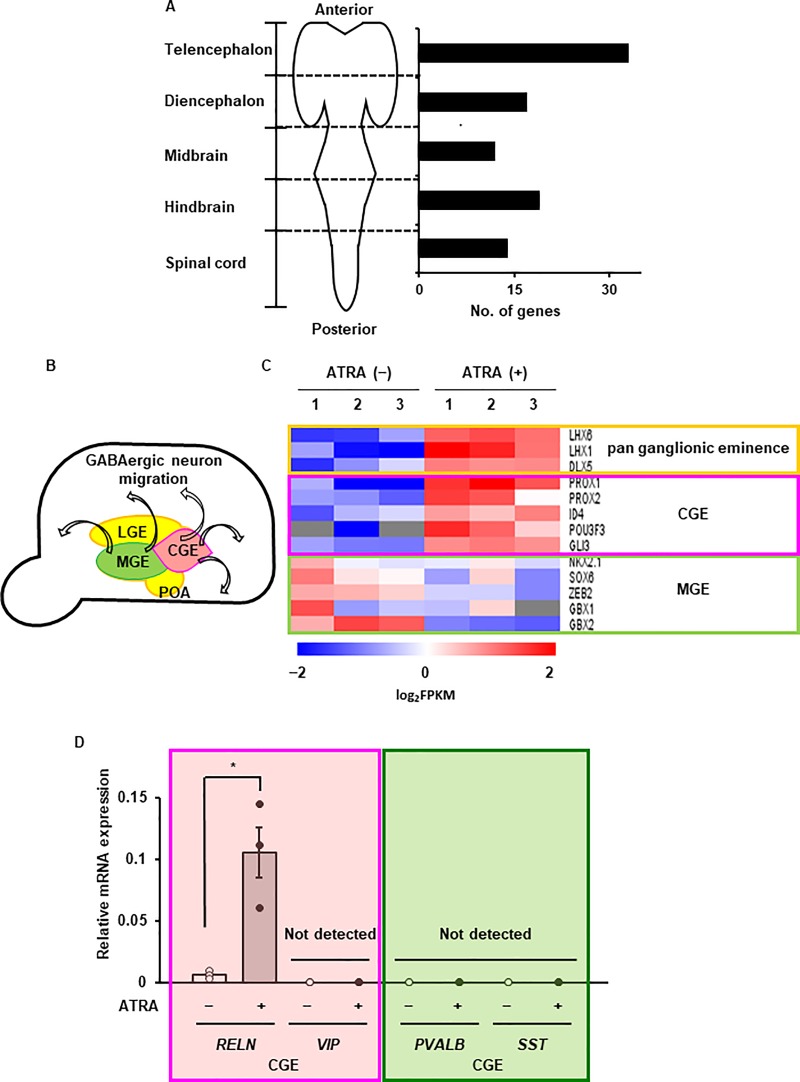
Regional identity of ATRA-treated canine DFATs.(A) The number of differentially expressed regional genes (P < 0.05) in ATRA-treated DFATs. (B) Schematic diagram illustrating that the medial ganglionic eminence (MGE) and the caudal ganglionic eminence (CGE), but not the lateral ganglionic eminence (LGE) and preoptic area (POA), are the primary sources of cortical GABA interneurons. (C) Heatmap illustrating the expression of the pan ganglionic eminence, MGE and CGE genes, in canine DFATs with or without ATRA treatment. (D) The expression of the cortical interneuron subtype markers reelin (RELN), vasoactive intestinal peptide (VIP), parvalbumin (PVALB), and somatostatin (SST). Data are shown as the mean ± standard error of three independent experiments. *P < 0.05.